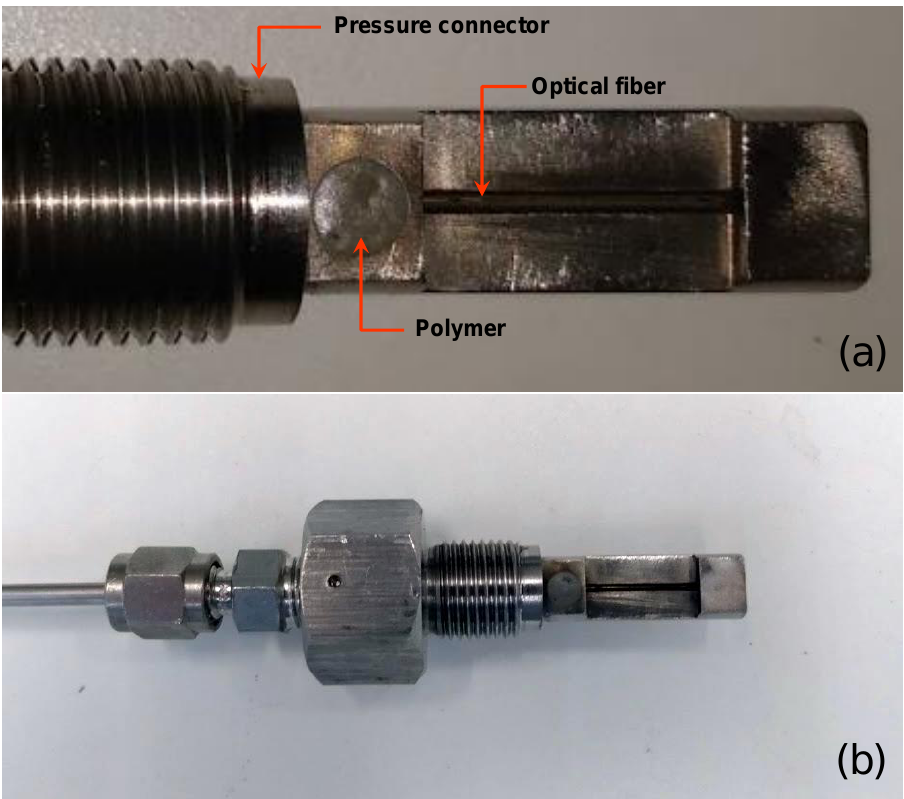
Figure 3. ( a ) Hole of a pressure connector filled with the metallic polymer and ( b ) the pressure connector using the polymer as a sealing technique.